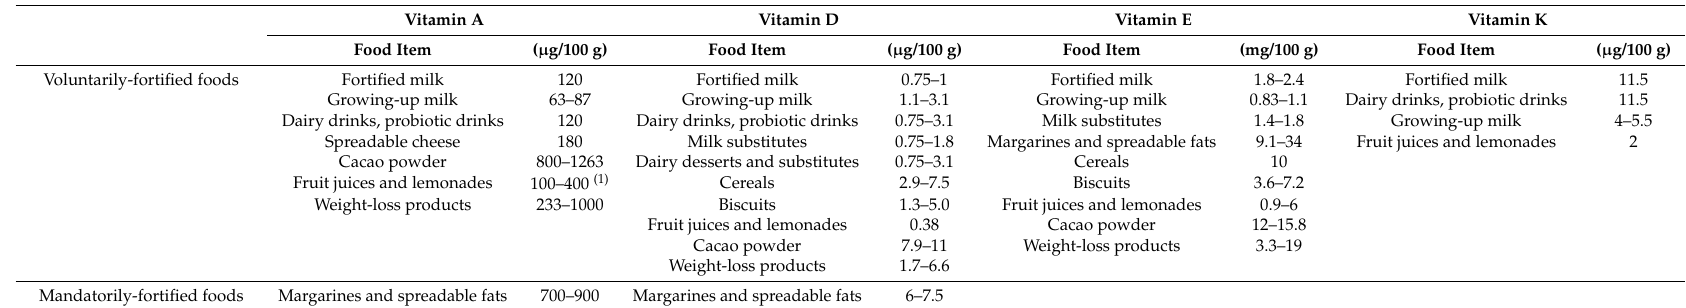
Table 1. Overview of the inventory of foods fortified with vitamins A, D, E and/or K and corresponding fortified value, suitable for the target population, Belgian study on the intake of vitamin A, D, E and K (VITADEK-study)